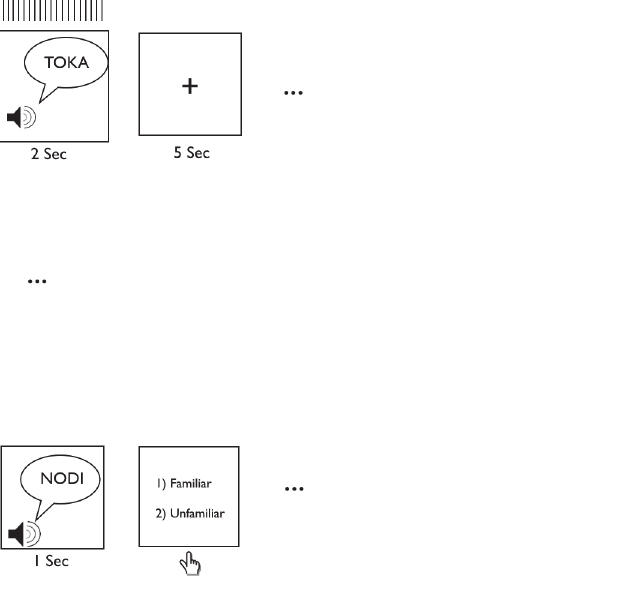
Fig 1. Illustration of the study